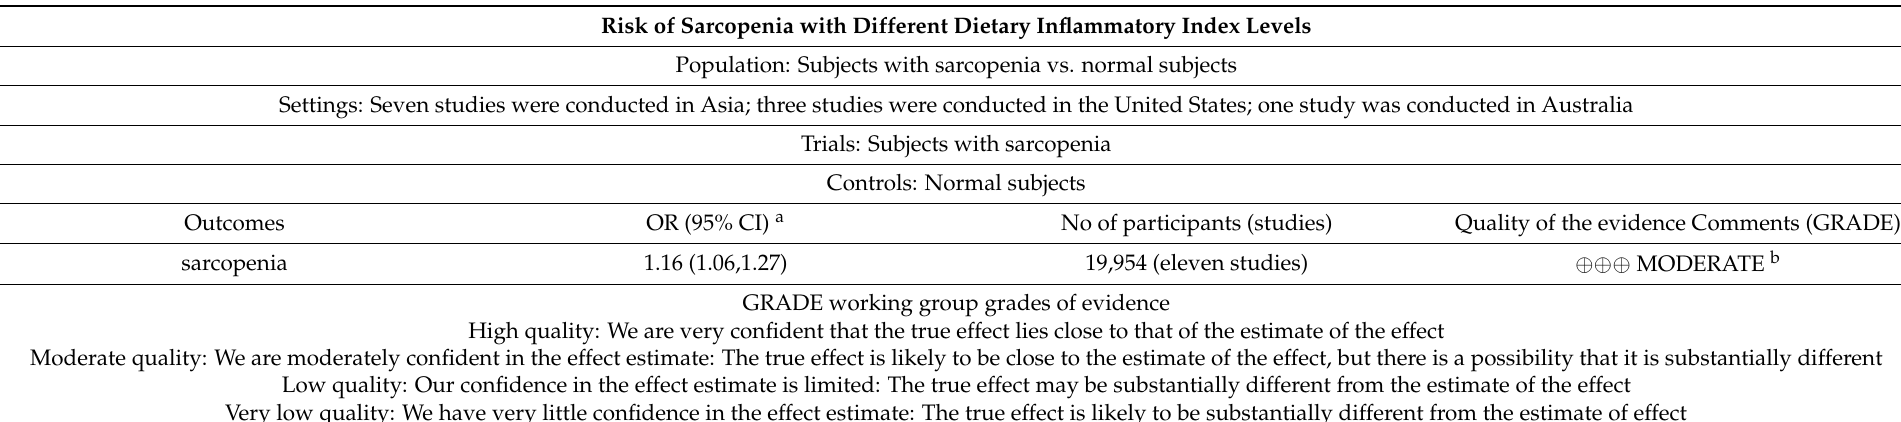
Table 2. The Summary of Findings (SoF) with GRADE system.